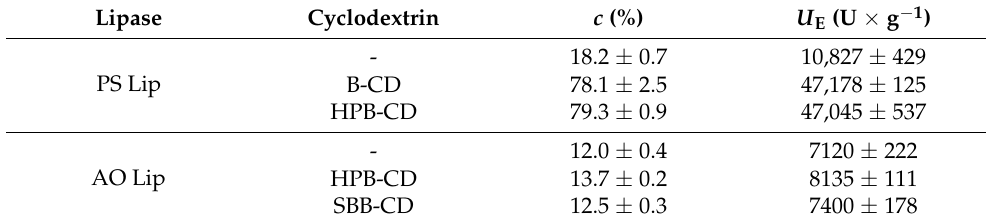
Table 1. Effect of cyclodextrins on the conversion ( c , %) in hydrolysis of p -NPP in FeSSIF catalyzed by lipase from Burkholderia cepacia (PS Lip) and from Aspergillus oryzae (AO Lip) and on the specific enzyme activity ( U E , U × g − 1 ).